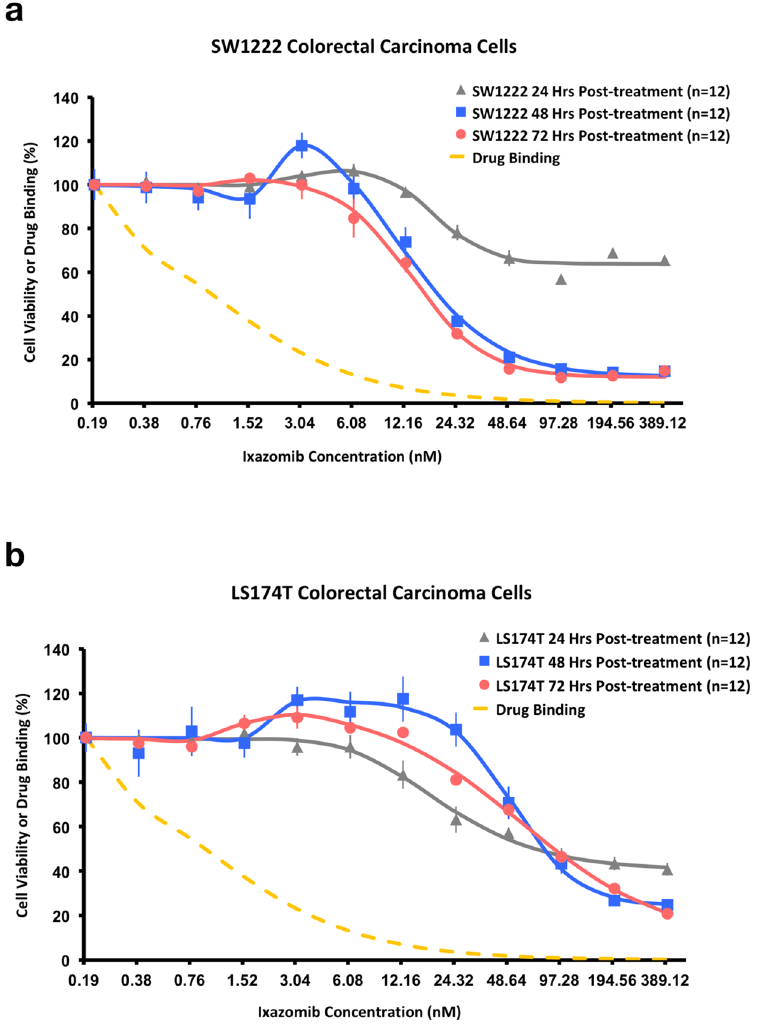
Figure 1. Dose-response curves showing cell viability as a function of Ixazomib concentration, measured with the MTT assay, at 24, 48 and 72 hours post-dosing, in SW1222 (n = 12) ( a ) and LS174T (n = 12) ( b ) cells (data points are mean ± standard error). These in vitro results show that cell viability decreases at higher Ixazomib doses ( > 12 nM in SW1222 and > 24 nM in LS174T) and that growth is stimulated at lower doses ( < 6 nM in SW1222 and < 24 nM in LS174T). SW1222 cells are more sensitive to Ixazomib than LS174T cells, which is in keeping with their K-Ras mutation status. Dashed lines show the Ixazomib binding estimates, which is a measure of the percentage of receptors that remain unbound (using ( K i = 0.93 nM, as a function of concentration; as concentration increases, the greater the percentage saturation of binding sites 5 ). Data points are mean ± standard